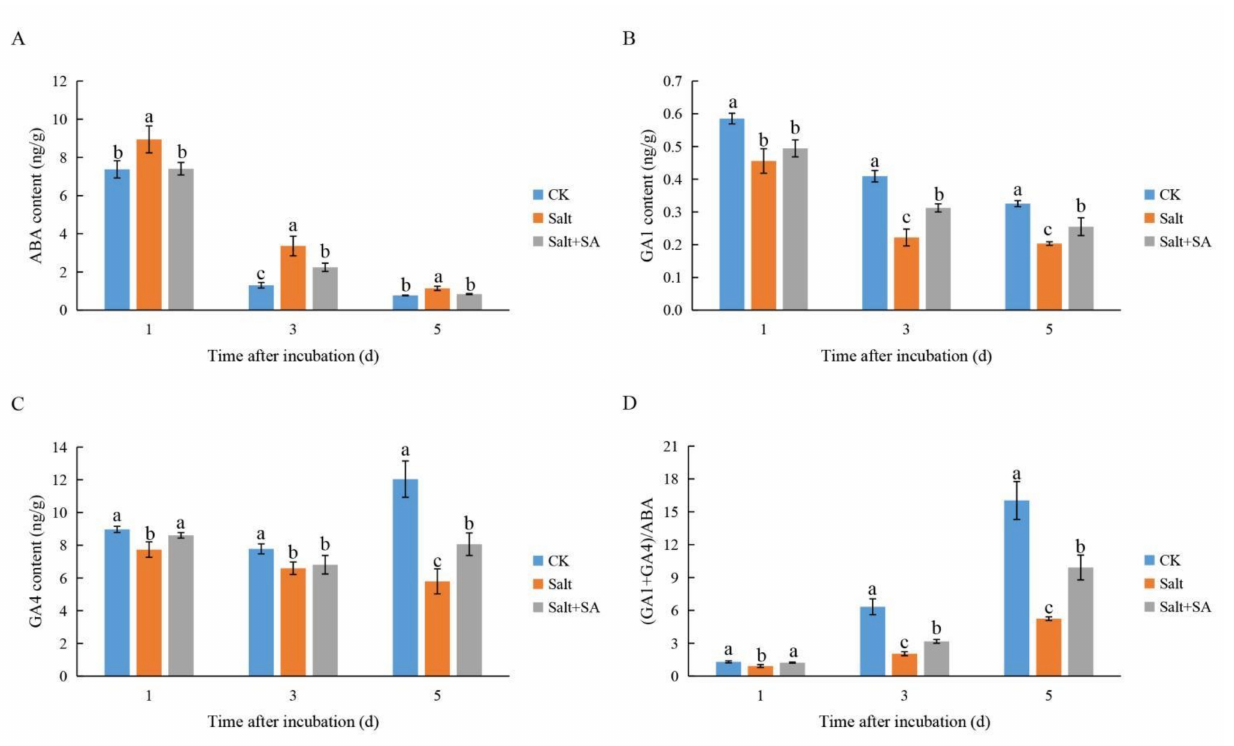
Figure 7. Effect of exogenous salicylic acid (SA) on endogenous hormones in rice seeds under salt stress. Seeds of Nipponbare were incubated in distilled water (CK), 150 mM NaCl (Salt), and 150 mM NaCl + 0.1 mM SA (Salt + SA) for 1, 3, and 5 days. The content of abscisic acid (ABA) ( A ), GA1 ( B ), and GA4 ( C ) in seeds from the different treatments and incubation times are compared, along with values of (GA1 + GA4)/ABA ( D ). Data are presented as means ± SE. Different lowercase letters indicate significant differences between treatments ( p <